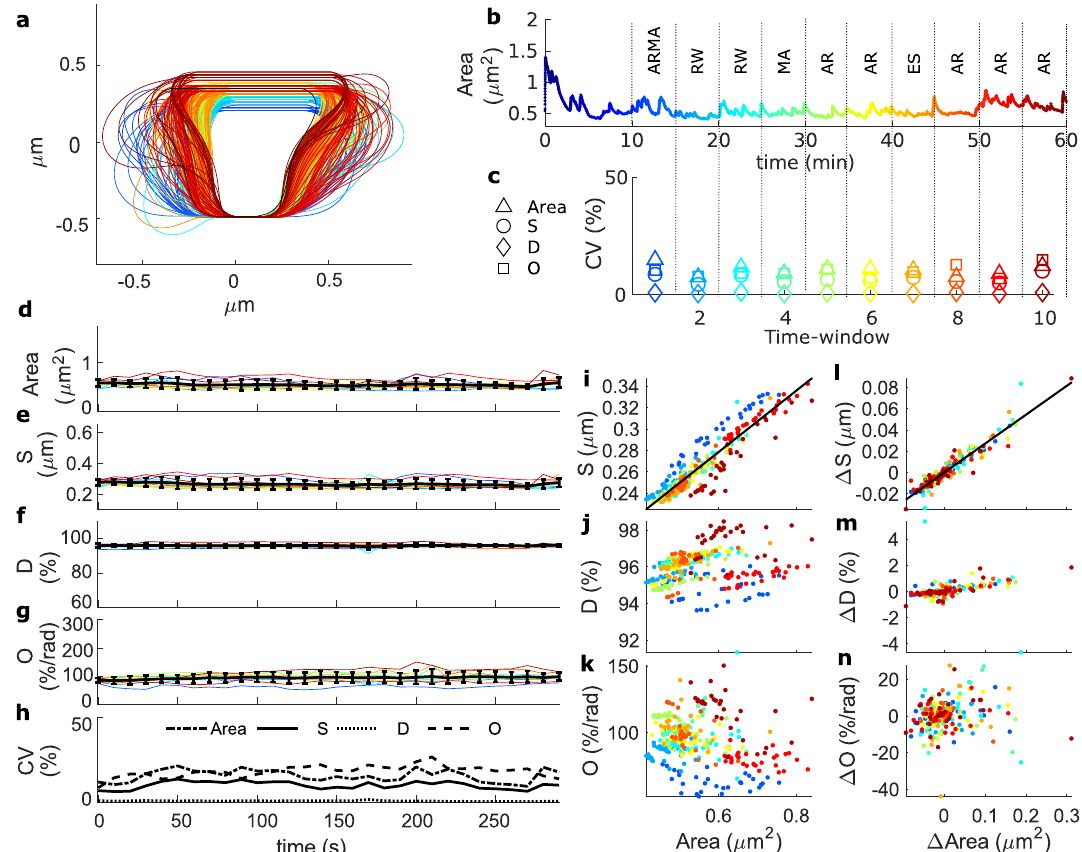
Figure 5. Shape descriptors from the model simulation. ( a ) Spine shapes resulting from the model simulation every 10 s, color-coded from 0 min (dark blue) to 60 min (dark red). ( b ) Spine area evolution over time corresponding to the simulation in ( a ), dotted lines indicate the 5 min windows, the spine number and the best fit of an ARIMA model (abbreviations as in Supplementary Information, Table S1). ( c ) Coefficient of variability of the shape descriptors for each time window. ( d–g ) Shape descriptors over time for the 5 min windows (spines in a ) of the simulation. As in the experimental data, the values were sampled every 10 s. ( h ) Coefficient of variability of shape descriptor evolution over time. ( i–k ) Spine area against S , D and O . Each dot represent the value for a certain time point and color-code corresponds to the respective 5 min window. Black lines correspond to a linear least-squares fit with a significant Pearson’s correlation coefficient of 0.93 in ( i ) (p-value < 0.01 using a Student’s t distribution). ( l–n ) Difference in spine area against (cid:31) S , (cid:31) D and (cid:31) O , respectively. ( l ) Has a significant Pearson’s correlation coefficient of